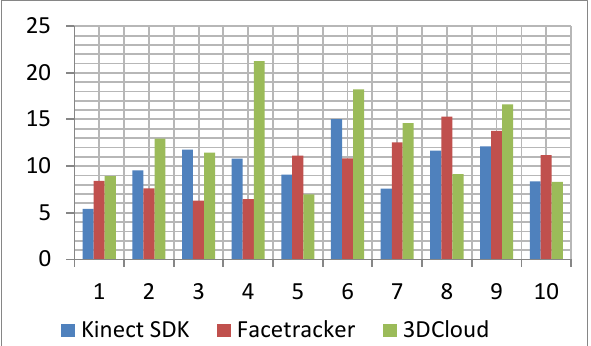
Figure 26. Mean RMSE (in degrees) for the roll for each